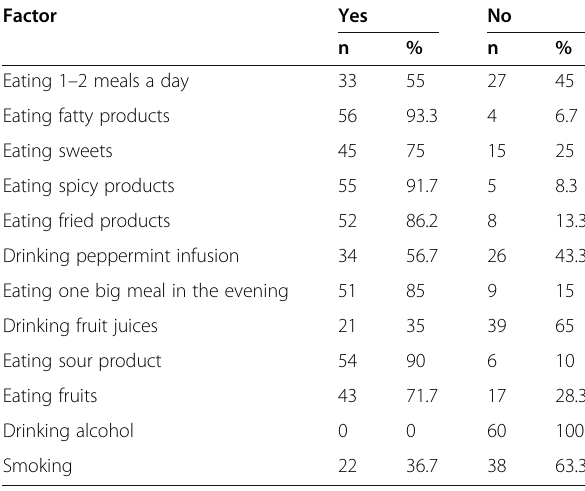
Table 2 Sample distribution according to dietary risk factors